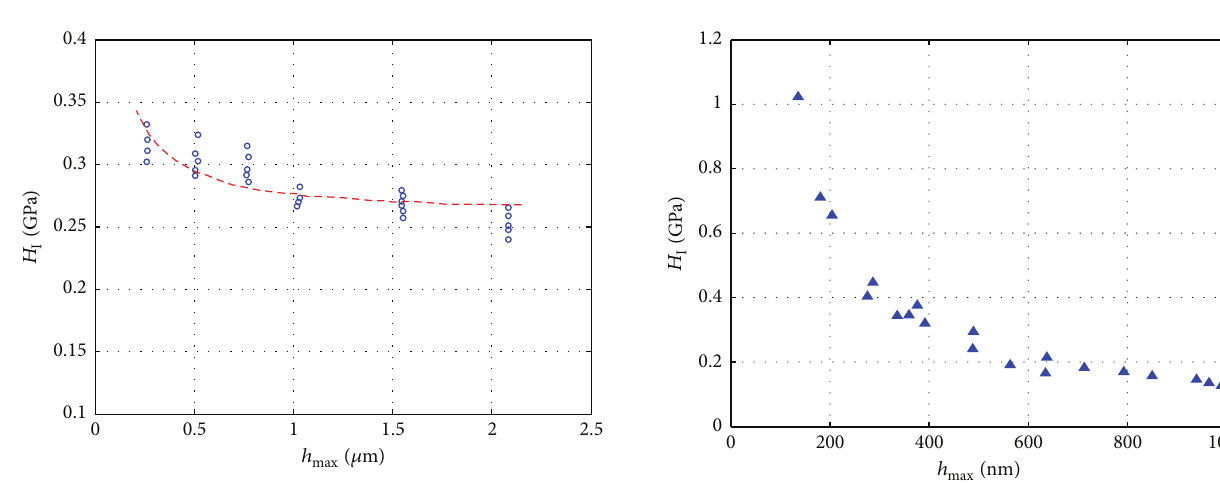
Figure 23: Indentation hardness of silicon elastomer determined with a Berkovich tip and the same loading and unloading rates of 150 𝜇 N/s [37].